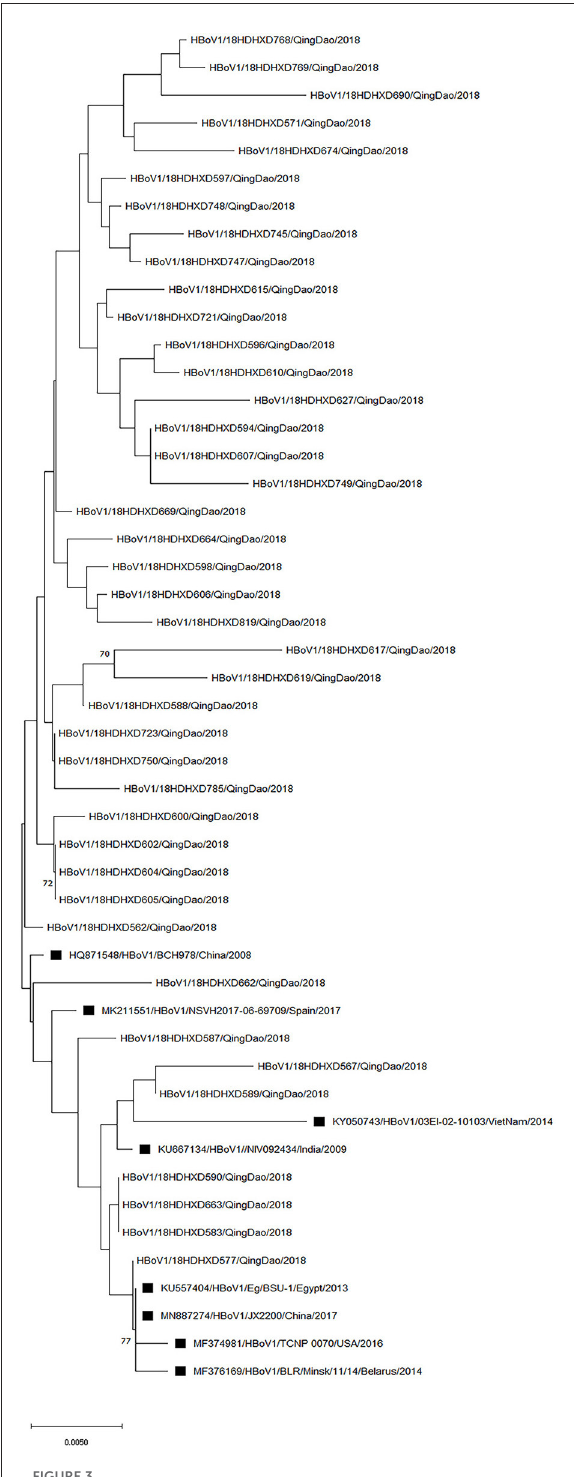
FIGURE3 Phylogenetic analysis of the partial VP1/VP2 nucleotide sequences of 41 HBoV1 strains from patients. A phylogenetic tree with 1,000 bootstrap replicates was generated using the maximum likelihood method with MEGA X software. Only bootstrap values > 70% are shown on the branch. HBoV1 sequences from Genbank are marked with (cid:4)